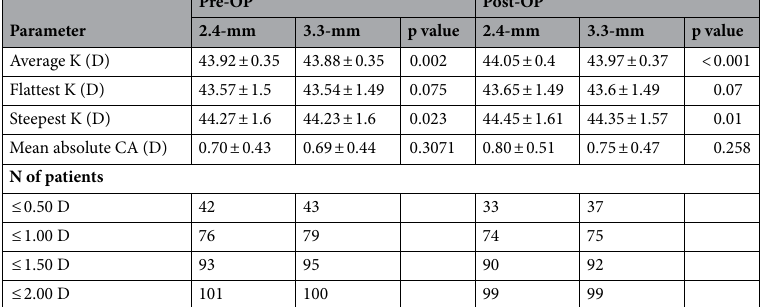
Table 2. Pre-operative and post-operative corneal power measured with AL scan at 2 diameter zones. CA corneal astigmatism, D diopters, K keratometry, No. number, Pre-OP pre-operative, Post-OP